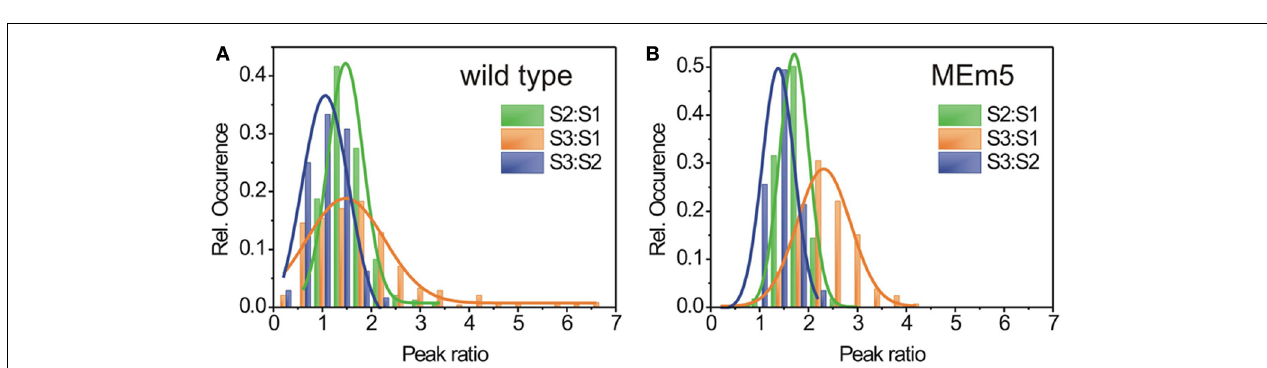
Gaussians (gray lines) to determine the relative contribution of the respective pigments to the excitation spectrum. The red curve depicts the summation of the three Gaussian distributions; round circles represent the raw data. Fluorescence intensity at the red region of the spectrum is slightly overrepresented due to higher excitation power at that edge of the spectrum.